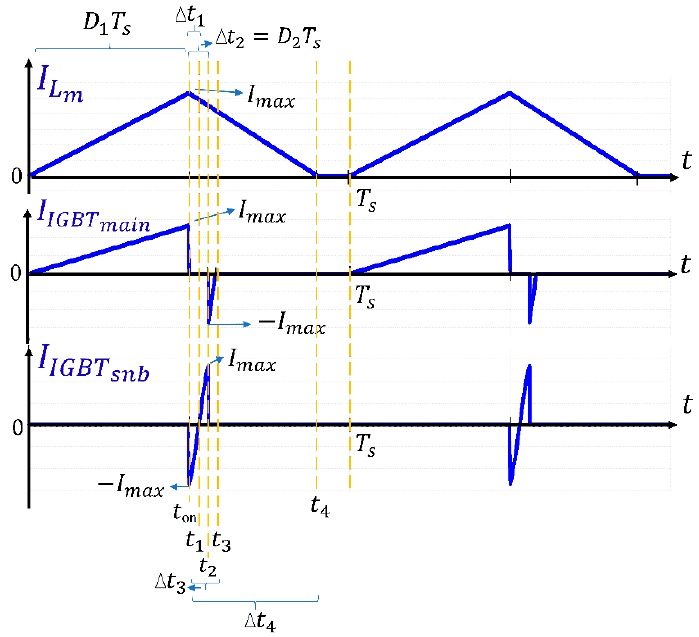
(top), I IGBT (top), 𝐼 (cid:3010)(cid:3008)(cid:3003)(cid:3021) m (cid:3288)